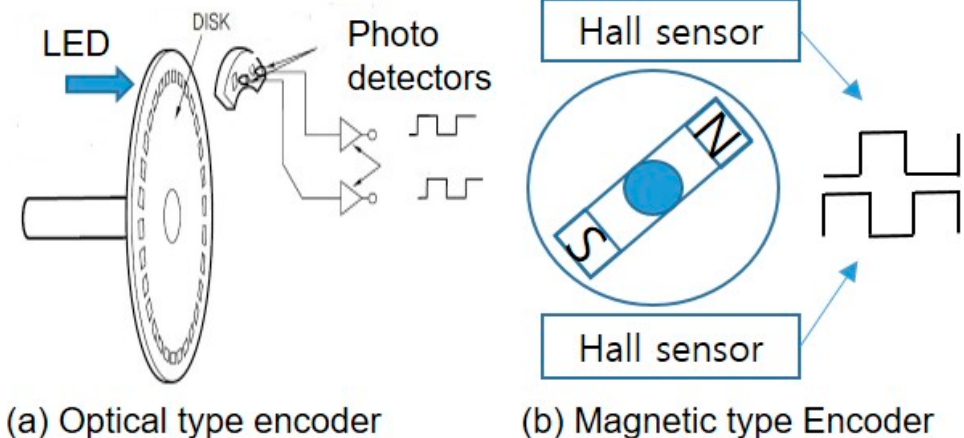
Figure 5. Two types of encoder for exercise DAQ device. Figure 6 shows the motion information acquisition operation. All system variables are initialized when booting starts from the system boot loader. System setup includes peripheral I/O setup, Bluetooth profile setup, memory index processing, and display initialization. Bluetooth connection is checked after initialization completes. The system only measures and stores exercise information if it is not connected, whereas